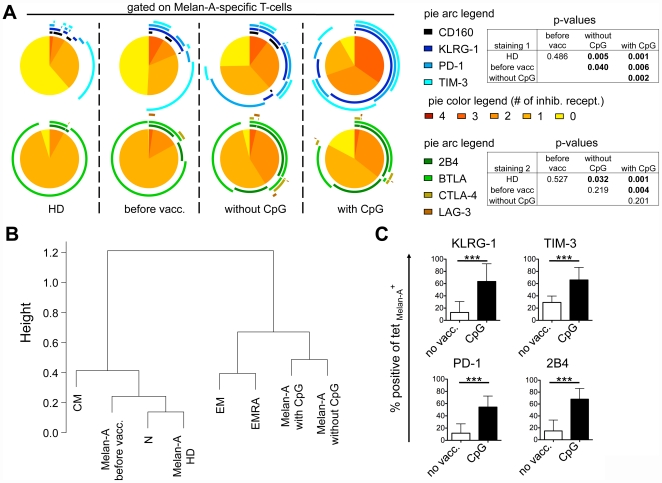
Inhibitory receptor expression by Melan-A specific CD8 T-cells depending on vaccination.(A) Co-expression of KLRG-1, TIM-3, PD-1 and CD160, and of LAG-3, BTLA, 2B4 and CTLA-4 by Melan-A specific CD8 T-cells. Blood samples from healthy donors (HD) or from patients before immunotherapy (before vacc.) or after peptide+IFA vaccination with or without CpG-ODN 7909 were enriched for CD8 T-cells using magnetic beads. Melan-A-specific CD8 T-cells were identified by staining with CD8-specific antibody and tetramer. Positivity for inhibitory receptors was defined respective to isotype controls. n = 4 for HD; n = 3 for before vacc.; n = 9 for after vaccination without CpG-ODN and n = 11 for after vaccination with CpG-ODN. Colors of the pie arcs depict the expression of individual inhibitory receptors, while the color in the pie depicts the number of co-expressed inhibitory receptors. Co-expression was analyzed with SPICE 5.2. p-values of the permutation test are shown in tables next to the corresponding pie charts. (B) Hierarchical clustering based on co-expression data of the eight inhibitory receptors shown in A, including the four differentiation subsets (N, CM, EM, EMRA) of total CD8 T-cells. (C) Mean expression and SD of four inhibitory receptors upregulated on Melan-A-specific T-cells with vaccination. Data from HD and from patients before vaccination were pooled for the group without vaccination (no vacc.). n = 7 for no vacc.; n = 9 for vaccination with CpG-ODN.